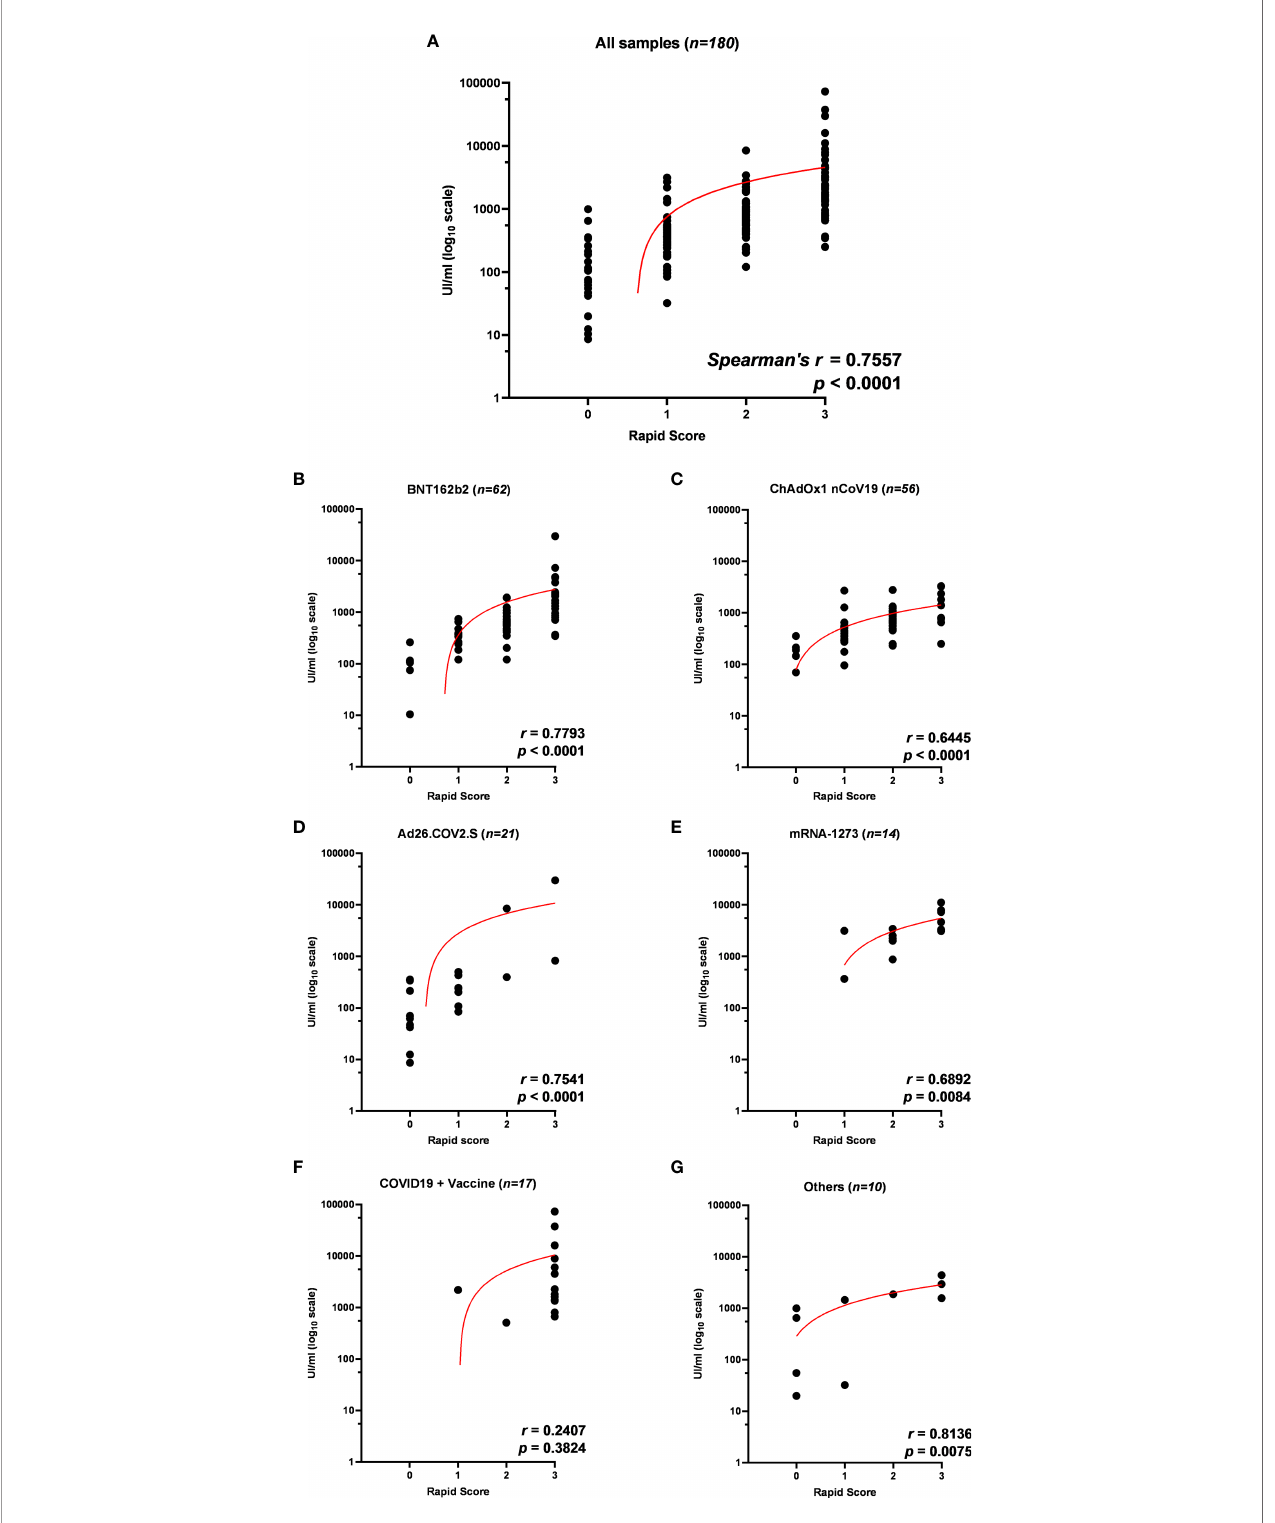
FIGURE 4 | (A) Correlation of anti-receptor-binding domain (anti-RBD) antibody titer to rapid test scores for IgG/Neutralizing antibodies in sera from 180 participants in the study and within each vaccination group: (B) BNT162b2, (C) ChAdOx1 nCov19, (D) Ad26.COV2.S, (E) mRNA-1273, (F) COVID19 + vaccine, and (G) others. Trendlines, Spearman ’ s r , and p -values are also reported (statistical signi fi cance for p <